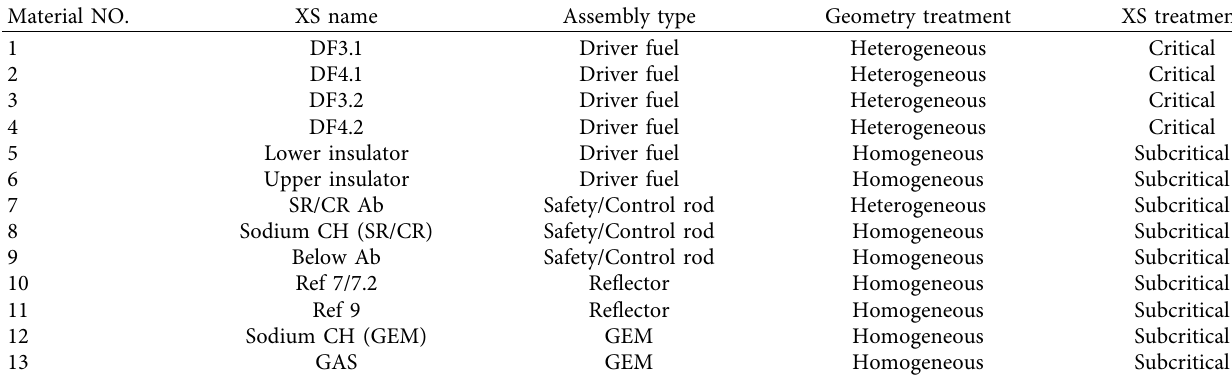
Table 2: Cell calculation treatment of FFTF LOFWOS test #13. Material